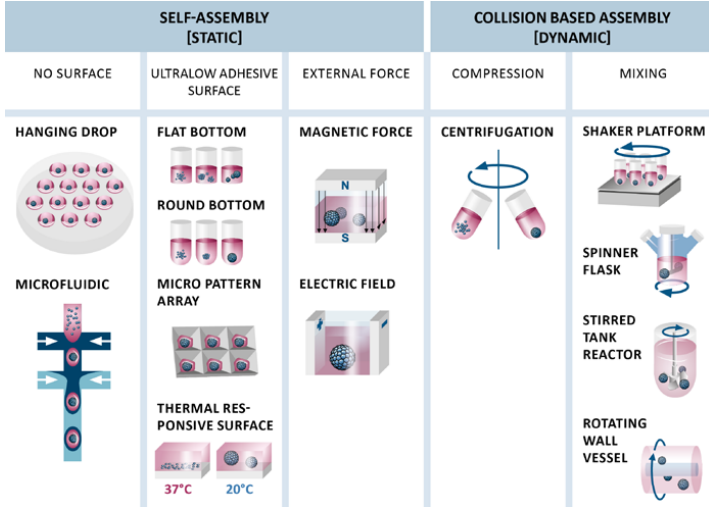
Figure 2. Different techniques for static cluster-based self-assembly and dynamic collision-based assembly of MSC aggregates. Self-assembly of MSCs can be forced using no or ultralow adhesive surfaces or external forces. Collision-based assembly is conducted by compression or